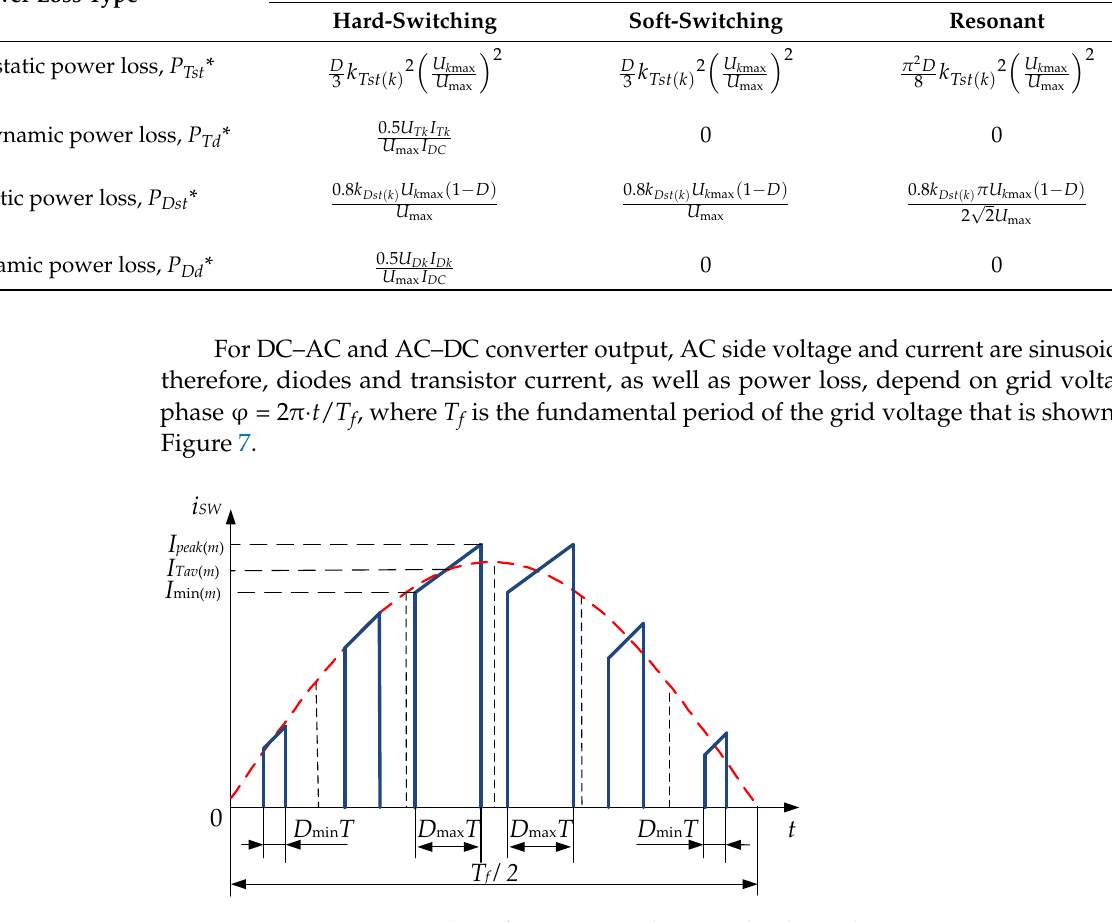
Figure 7. Transistor current shape for AC – DC and DC – AC hard-switching converters. The amplitude peak current values I peak(m) , I Tav(m) , and I min(m) are used to calculate the AC shaped current cost factor kc, whereas the power loss P con(AC)* analysis is performed based on the integration of instantaneous power loss P con(AC)* from Table 2, where duty cycle D is a function of power grid phase φ , D [0; D max ], and normalized with current i norm :